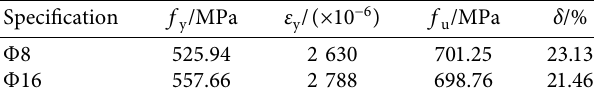
Table 2: Mechanical properties of steel